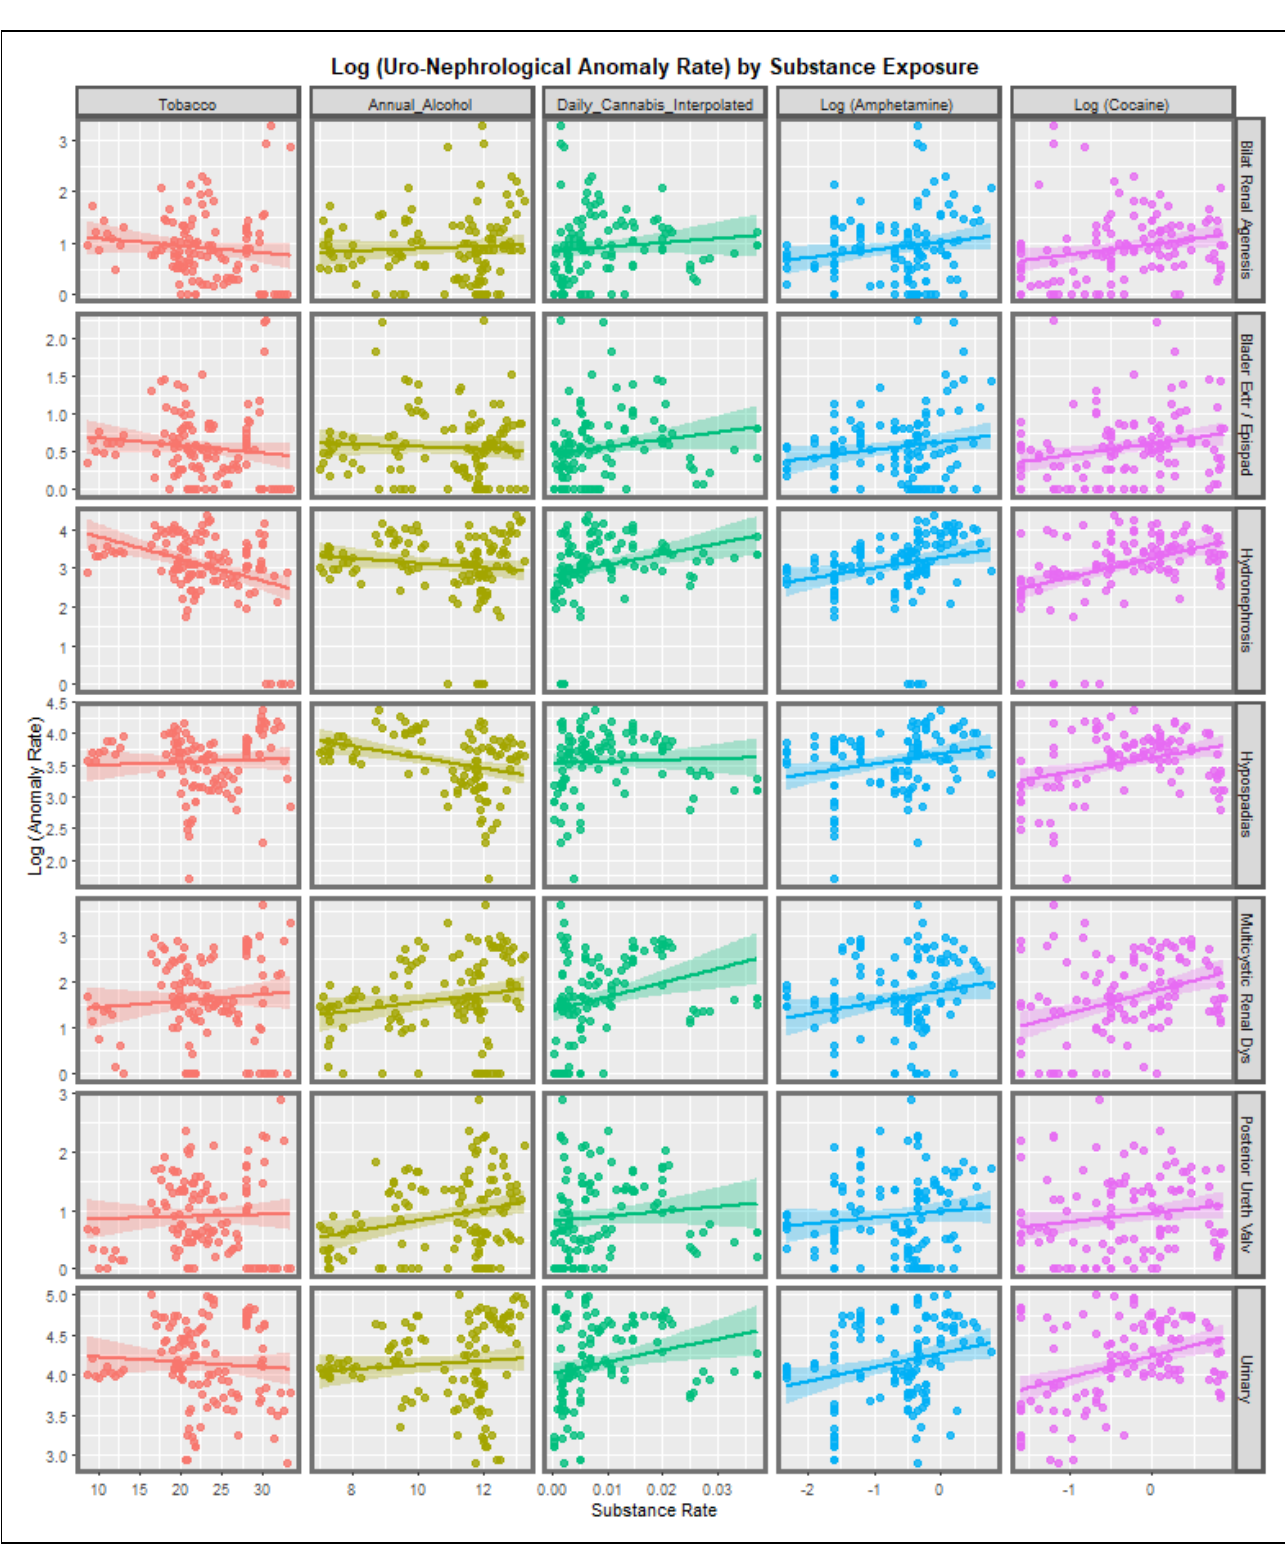
Figure 1. Bivariate plots of selected uronephrological congenital anomalies against various sub- stances.